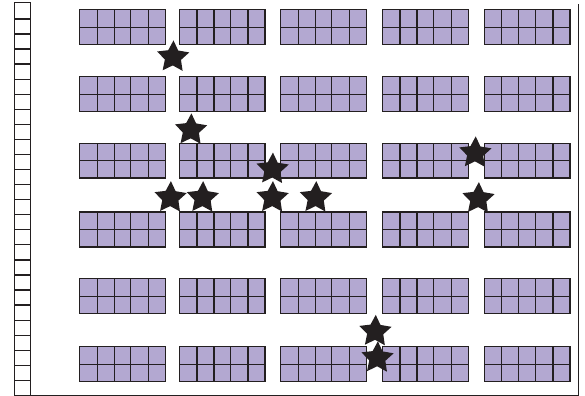
Figure 4: Rasterized storage environment.